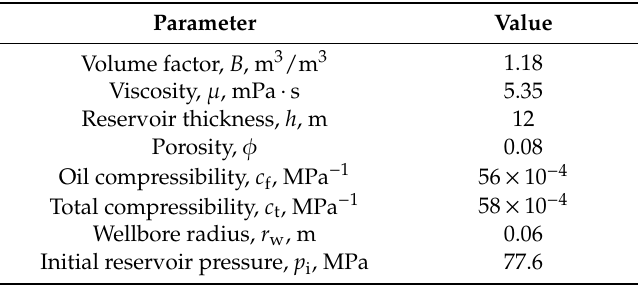
Figure 28. Production data for Well XHa. Table 12. Basic parameters of Well XHa.